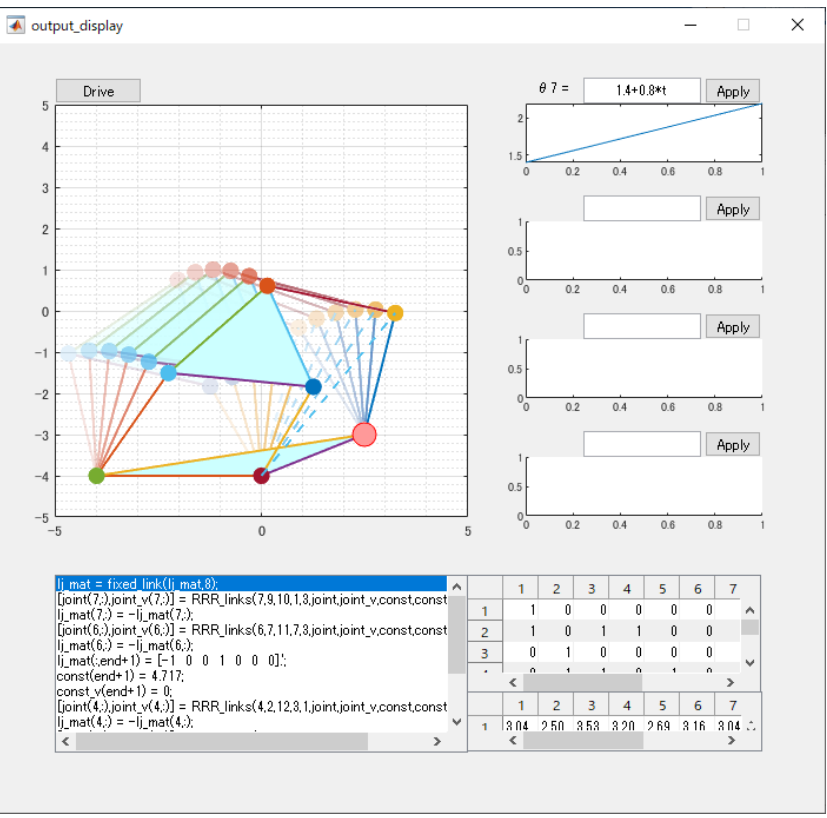
Figure 15. The motion simulation of 6-bar linkage mechanism according to the extracted procedure.